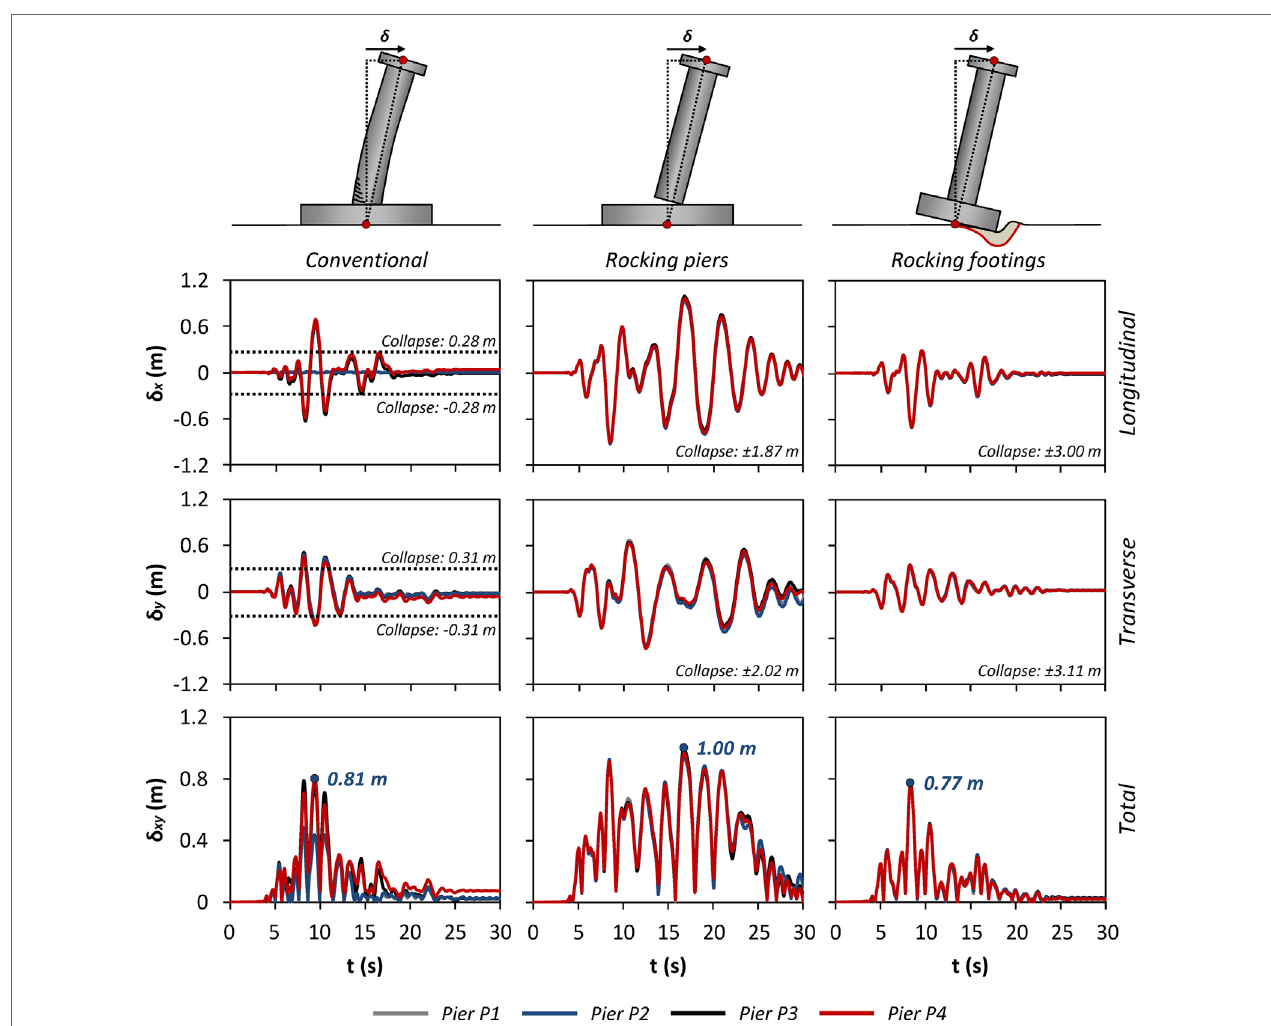
FigUre 9 | Comparison of the three design alternatives in terms of pier drift at each direction and total pier drift time histories δ ( t ) for all four piers of the bridge indicatively for Takatori